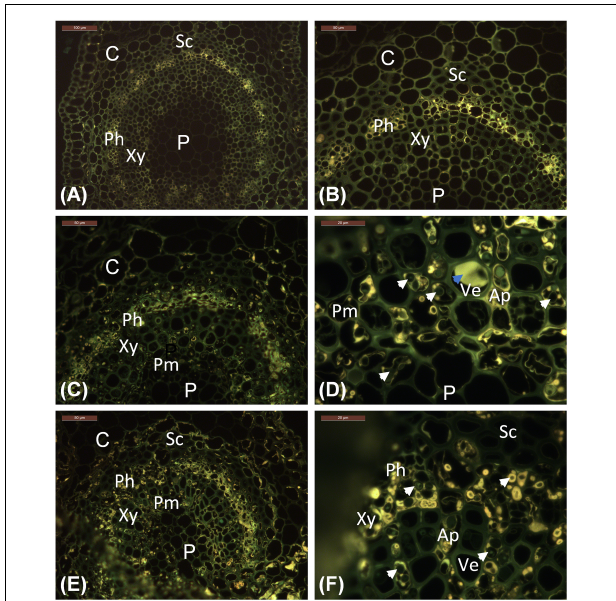
FIGURE 2 | Location of phenolics in leaflet veins, as indicated by bright yellow auto-fluorescence characteristic of polyphenolic compounds. (A,B) Stjørdal, asymptomatic vein. (C,D) Stjørdal, lesion area in a vein. (E,F) Norderås, lesion area in a vein. Examples of hyphae growing in axial parenchyma with phenolic deposits are indicated by white arrowheads. One example of tylosis with a vessel element is indicated by a blue arrowhead. Ap, Axial parenchyma; C, Cortex; Ph, Phloem; P, Pith; Pm, Perimedullary parenchyma; Sc, Sclerenchyma; Ve, Vessel elements; Xy,